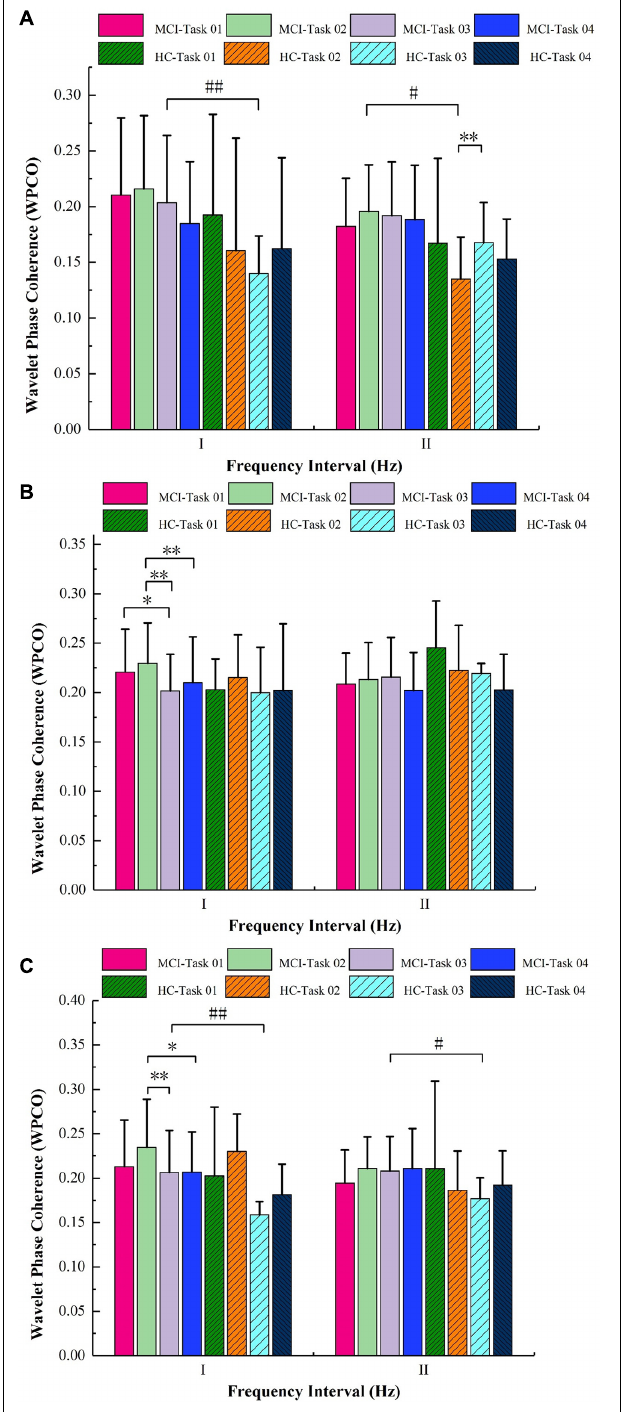
FIGURE 5 | Results of wavelet phase coherence (WPCO) in different brain regions among the groups under the four tasks. (A) WPCO of left prefrontal cortex–right occipital leaf cortex (LPFC–ROL), (B) WPCO of right prefrontal cortex–right motor cortex (RPFC–RMC), (C) WPCO of left prefrontal cortex–left motor cortex (LPFC–LMC). Significant levels are marked with # p < 0.05, ## p < 0.01, ∗ p < 0.05, ∗∗ p < 0.01. HC, healthy control; MCI, mild cognitive impairment.